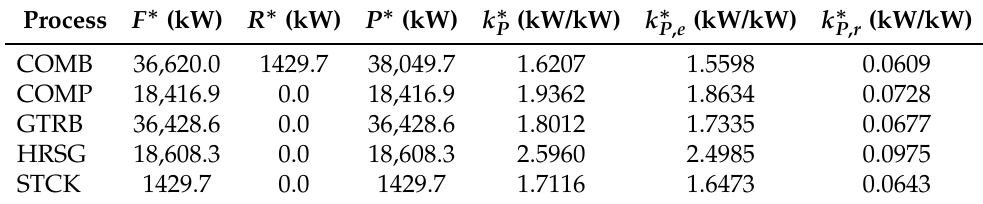
Table 9. Production direct exergy cost for TGAS